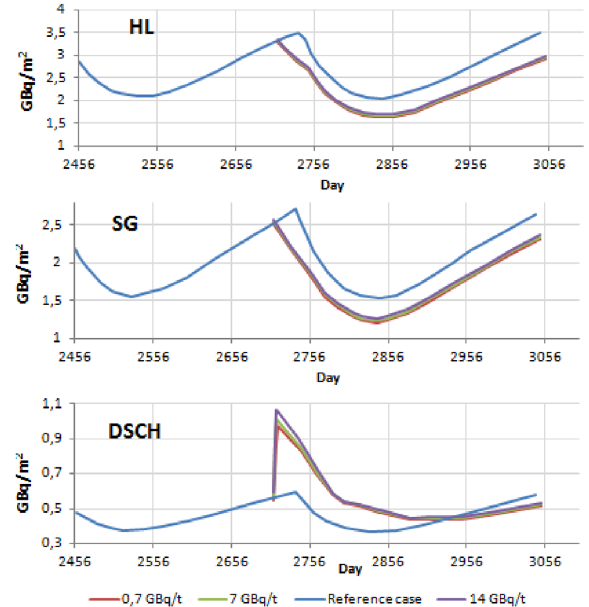
Fig. 6. 58 Co activities deposited on the hot legs (HL), the steam generators (SG) and the letdown lines (DSCH) in the case of a mid-cycle shutdown 1 month before the end of cycle.